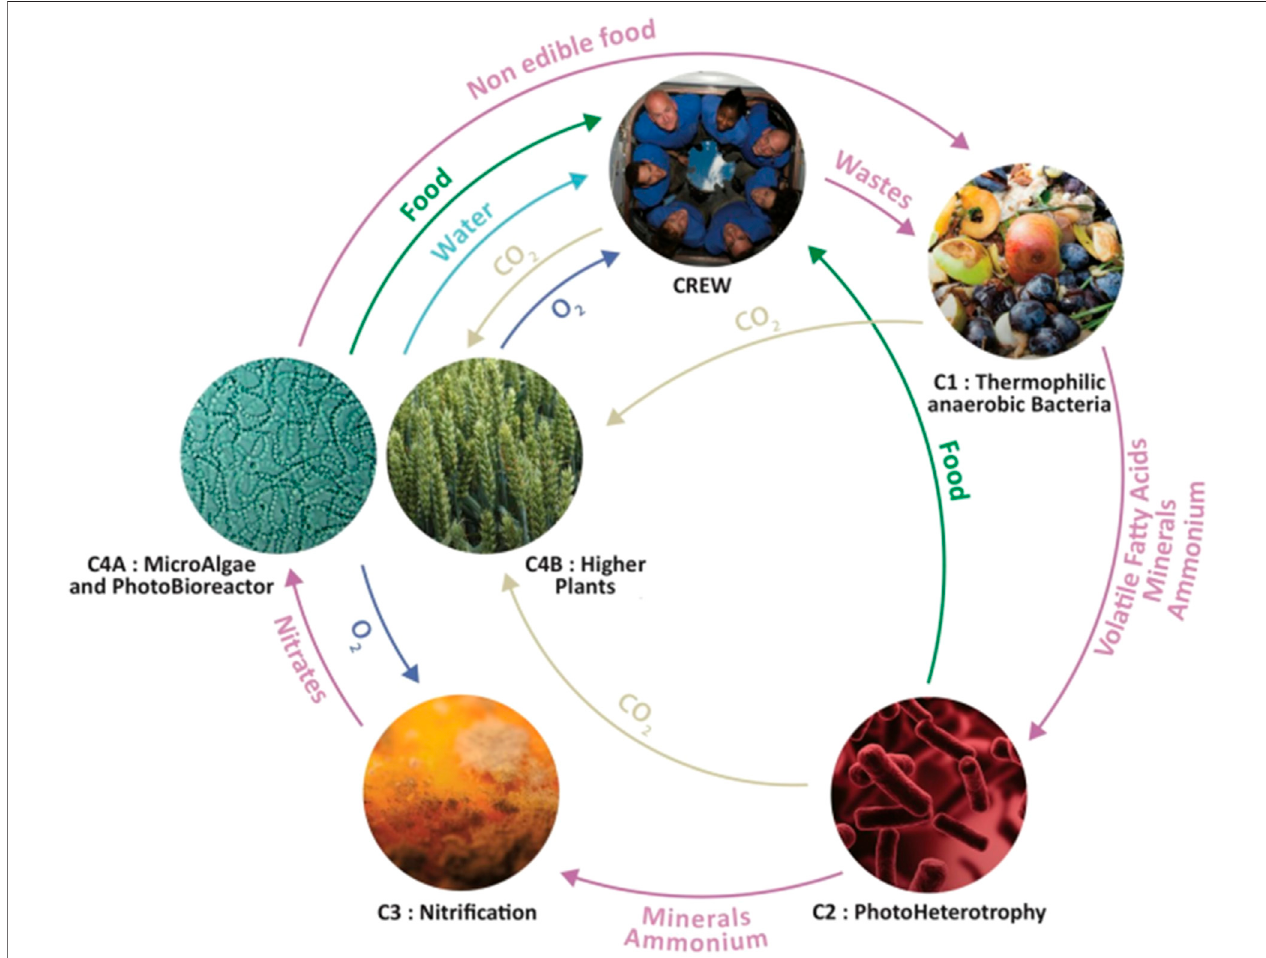
FIGURE 1 | Scheme of the MELiSSA loop concept. All the 5 compartments are presented in circles. Interphases with nutrient, water and gas exchanges are presented with arrows. Source: www.melissafoundation.org.